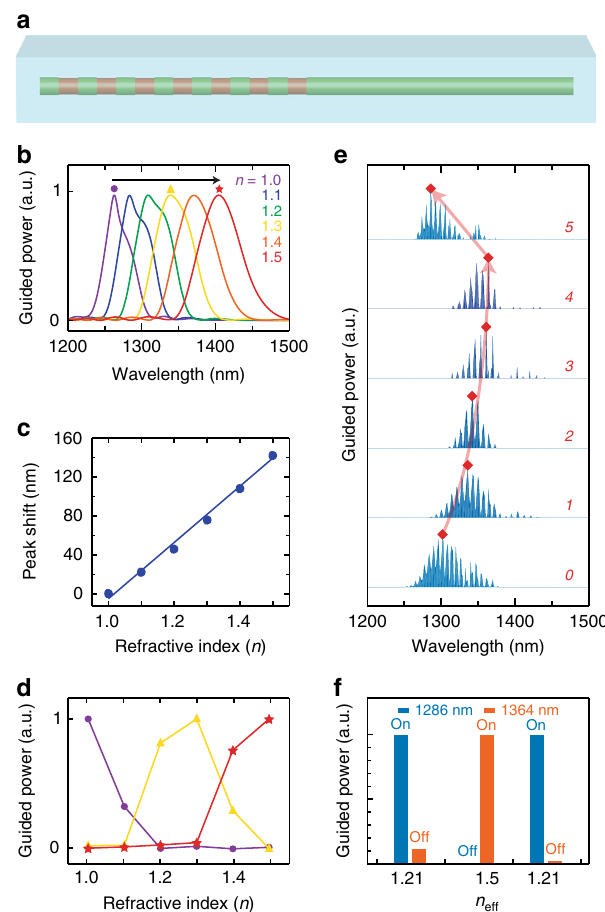
Fig. 5 Optical switching in a GSL-WG. a Schematic of a GSL-WG in which the refractive index, n , of the surrounding medium (blue) changes from 1 to 1.5. b Simulated guided power spectra for a GSL-WG with d = 280 nm, e = 250 nm, and p = 800 nm for n varying from 1 (blue) to 1.5 (red) in steps of 0.1. c Plot of guided peak position shift versus refractive index n . d Normalized guided power versus refractive index at wavelengths of 1262 nm (purple circles), 1338 nm (yellow triangles), and 1404 nm (red stars). Spectral positions correspond to the marker symbols in b . e Experimental guided power spectra of a NW WG with a GSL of d = 280 nm and p = 820 nm measured without PMMA (0), after sequential additions of up to 4 PMMA layers (1 – 4), and after removal of PMMA (5). Red diamonds and lines denote the spectral position with maximal guided power for each spectrum. f Normalized guided power at wavelengths of 1286 and 1364 nm derived from spectra labeled 0, 4, and 5 in e , which correspond to estimated effective indices of 1.21, 1.5, and